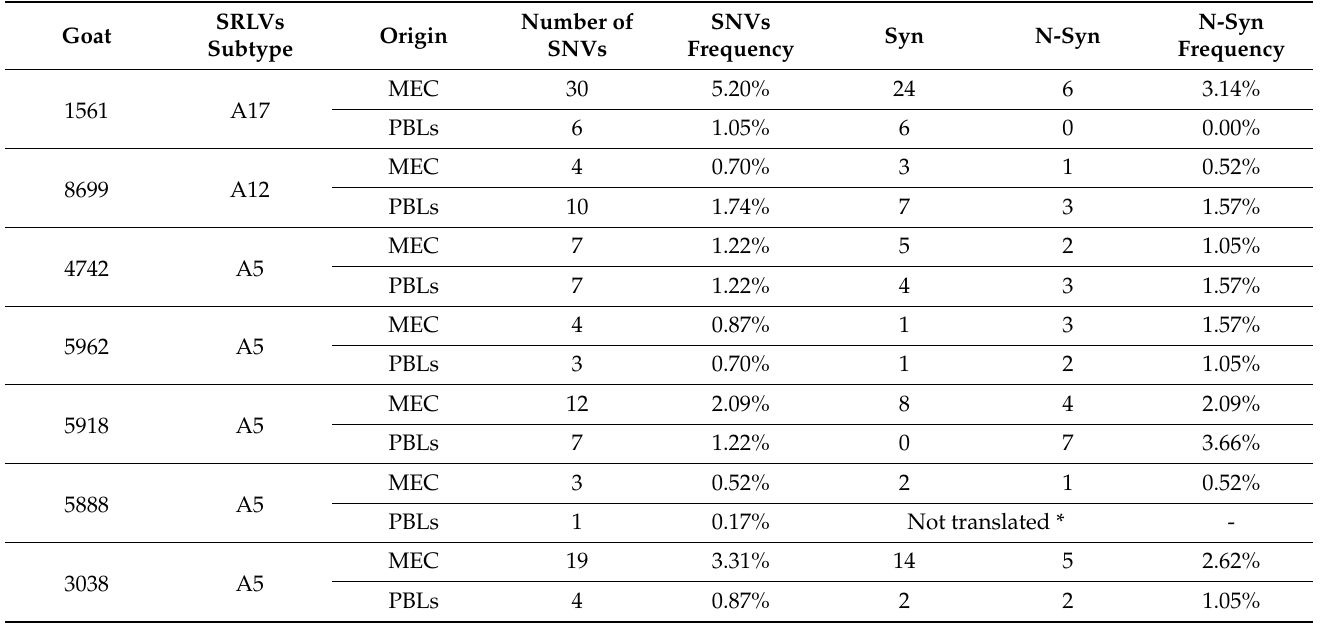
Table 2. Characteristic of SRLVs sequences derived from PBLs and milk epithelial cells (MEC) of goats analyzed in this study. Goat